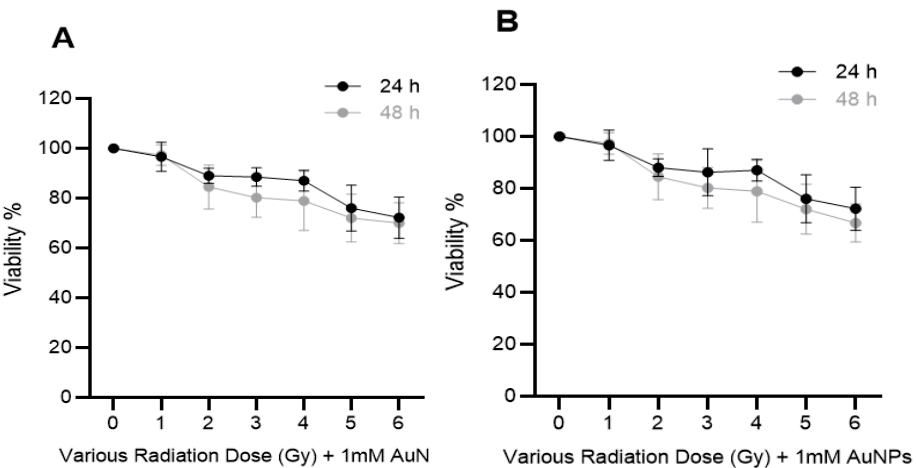
Figure 4. E ff ect of combination of IR and AuNPs on the viability of human cancer cells in vitro. A ) DU145 (prostate) and B ) A549 (lung) cancer cells were treated with 1 mM AuNPs for 24 h prior to